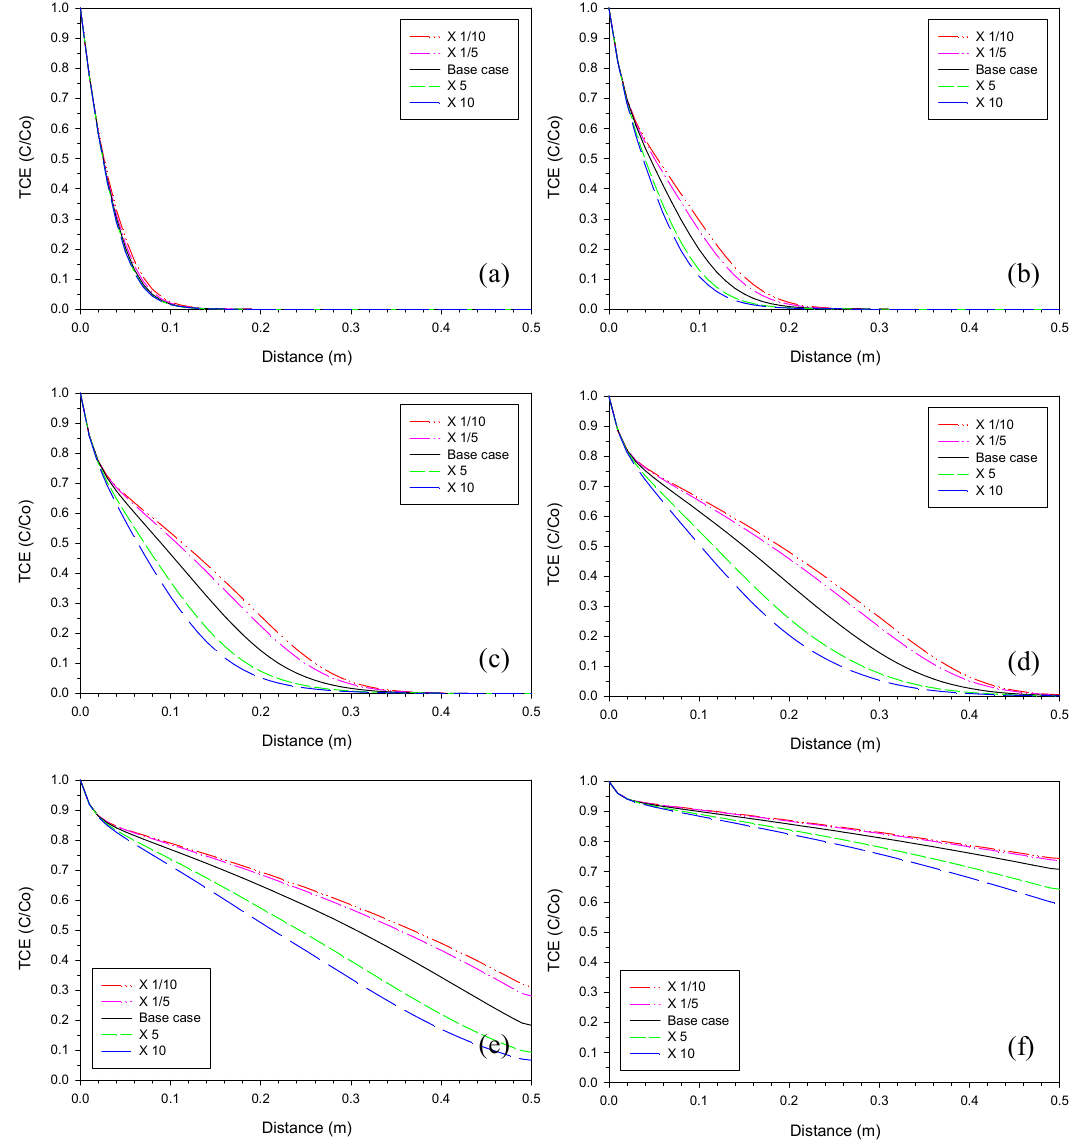
Figure 5. Sensitivity analysis of Fe 2 (OH) 2 CO 3 (s) precipitation rate. TCE profiles on ( a ) Day 4, ( b ) Day 25, ( c ) Day 54, ( d ) Day 87, ( e ) Day 164, and ( f ) Day 410 with value of the base case, × 1/10, × 1/5, × 5, and × 10.